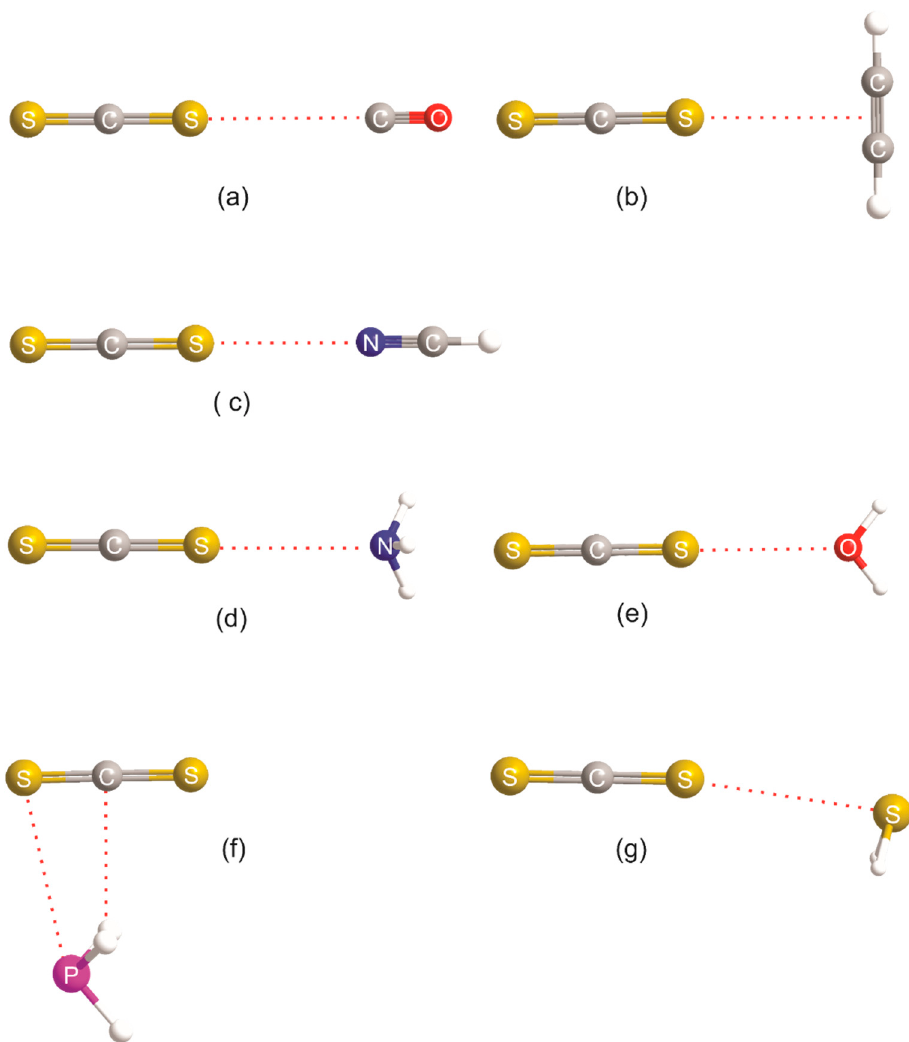
Figure 6. Molecular models drawn to scale of the geometries of B ⋯ CS 2 complexes calculated at the CCSD(T)/aug-cc-pVTZ level of theory, where B = CO, HCCH, HCN, NH 3 , H 2 O, PH 3 and H 2 S ( a – g , respectively).